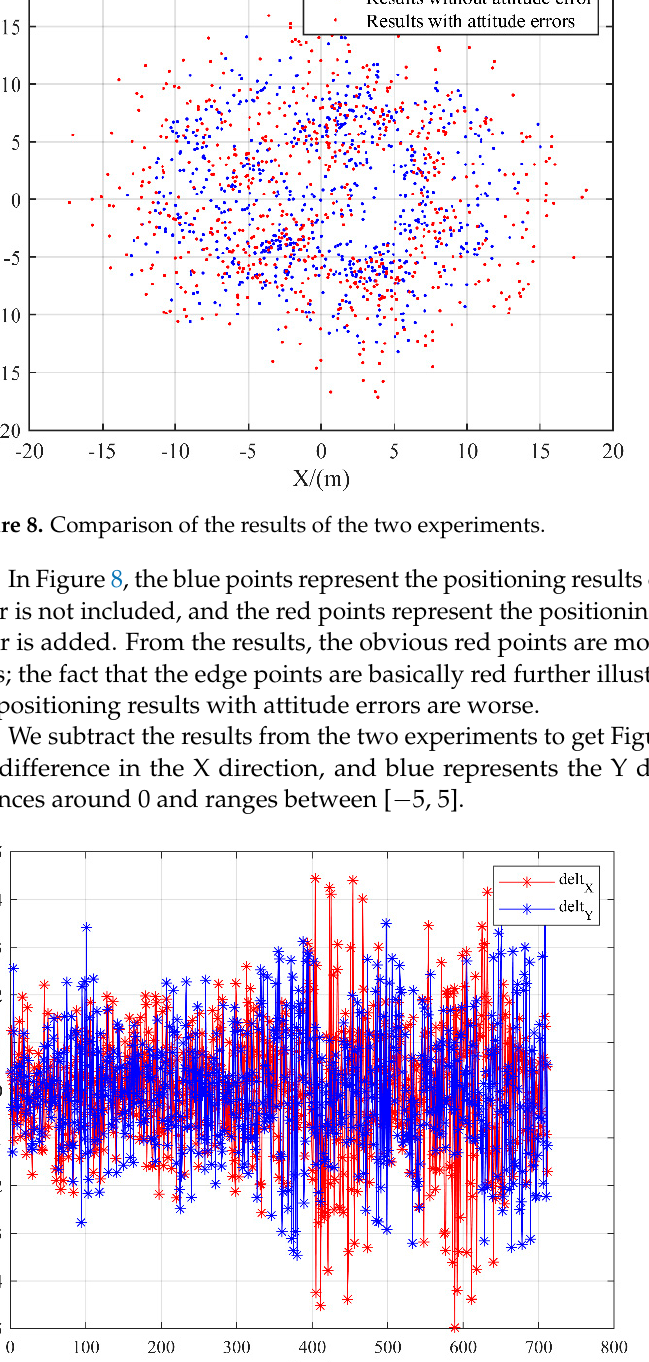
Figure 9. Comparison of deviation values in X and Y directions.